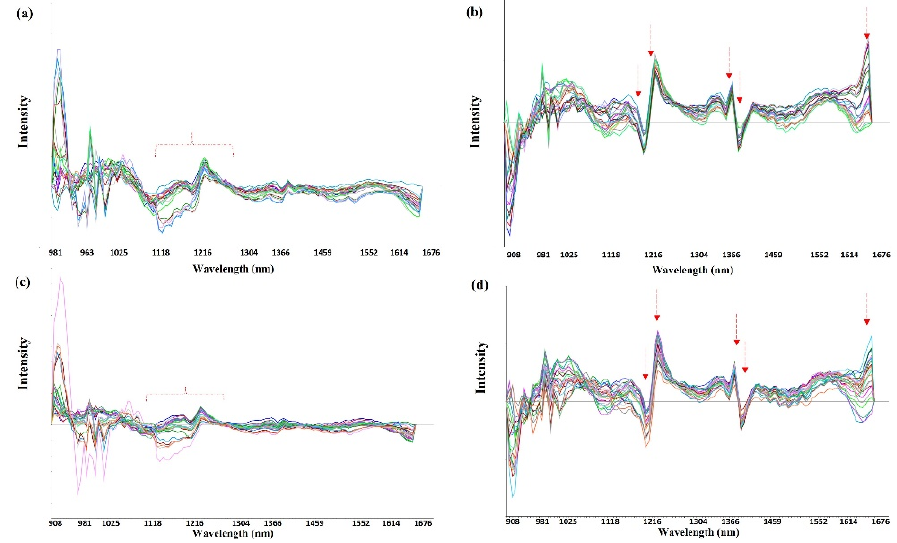
Figure 8. NIR accumulated spectra after data normalisation and a second derivative in the adsorption study for both drugs and two elastomeric materials. Key: ( a ) DJEA; ( b ) DJEN; ( c ) MJEA; and ( d ) MJEN.